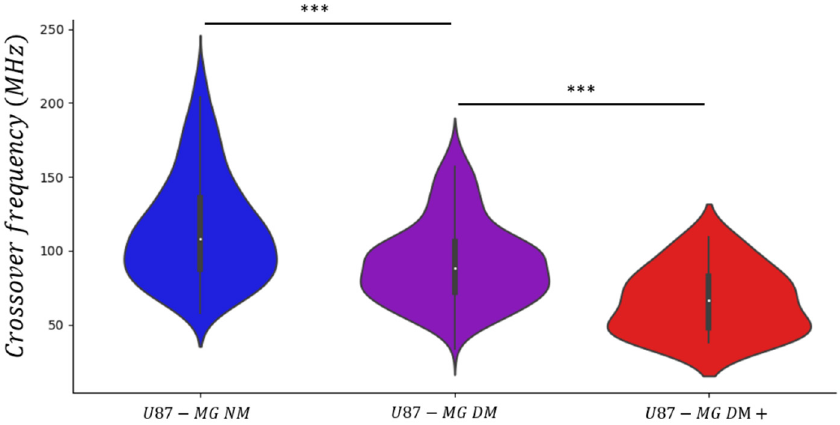
Figure 10. Graphic violin plot representation of U87-MG cells crossover frequency f x02 , cultured in three different conditions: (i) 5 days in Normal Medium (NM); (ii) 5 days in define medium (DM); (iii) 21 days in define medium (DM+). *** represents p -value <